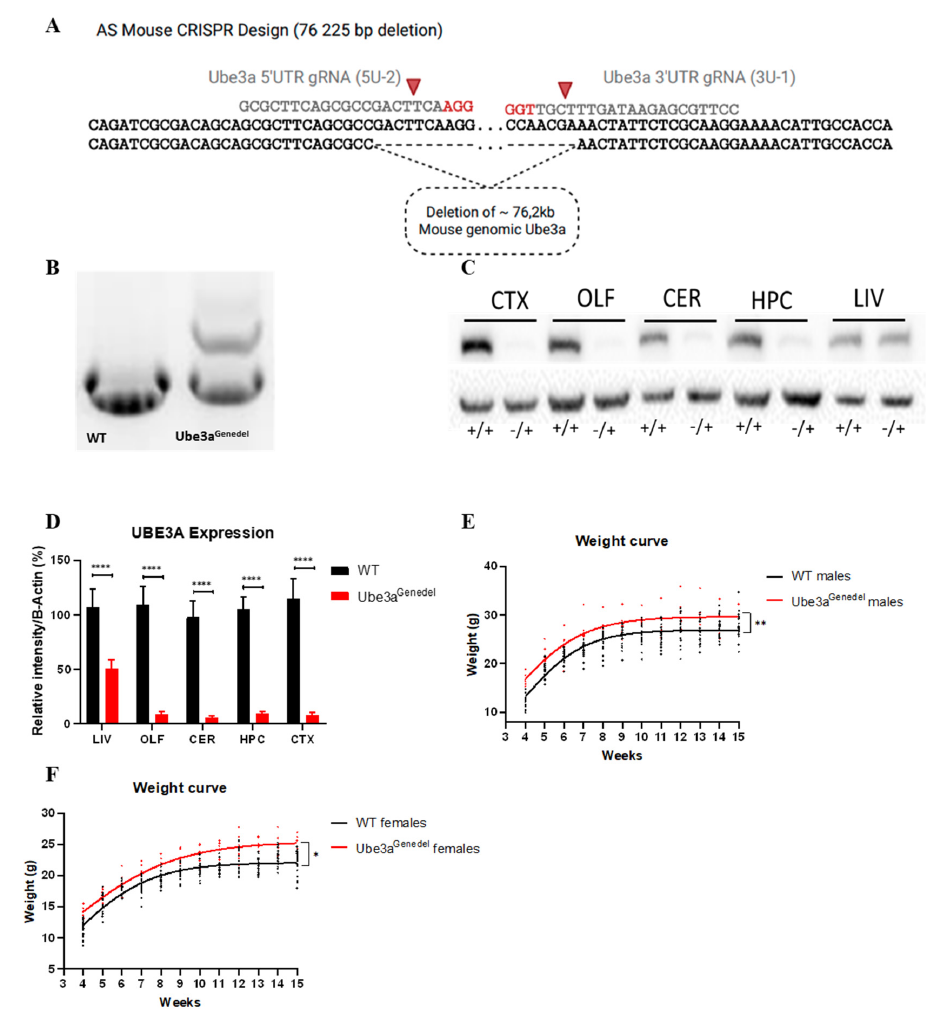
Figure 1. The Ube3a Genedel mouse model. ( A ) Schematic of the Ube3a Genedel deletion, a 76,225 bp deletion range from 58,878,821 to 58,955,045, Mus musculus strain C57BL/6J chromosome 7, GRCm39 (NC_000073.7). The gRNA generating the cut are indicated. ( B ) Representative amplification of WT control and Ube3a Genedel DNA, with the WT showing one band of 1183 bp and the Ube3a genedel showing an additional at 1602 bp. ( C ) A representative Western blot showing a near complete reduction in UBE3A in several brain regions and a decrease to half in liver tissue. ( D ) A quantification of the UBE3A expression from Western blot; two-way ANOVA main genotype effect p < 0. CTX: cortex, OLF: olfactory bulb, CER: cerebellum, HPC: hippocampus, LIV: liver. ( E , F ) Graph of weight recordings from 4 weeks to 15 weeks. All data represent means ± SD. Significant effects of genotype are indicated as * p < 0.05, ** p < 0.01 and **** p < 0.0001 for genotype significance.